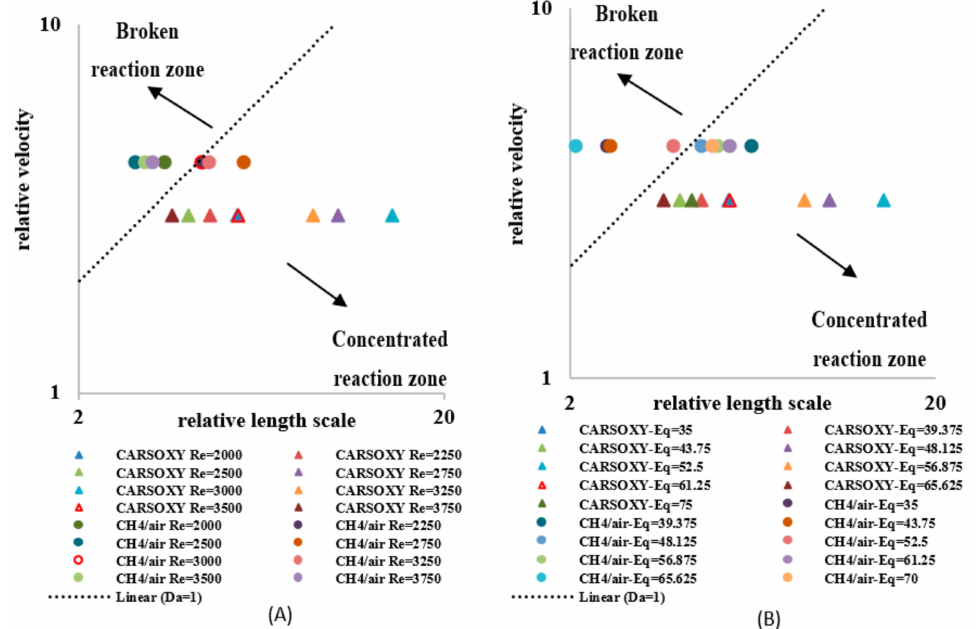
. V CH4 = 1 L/min and